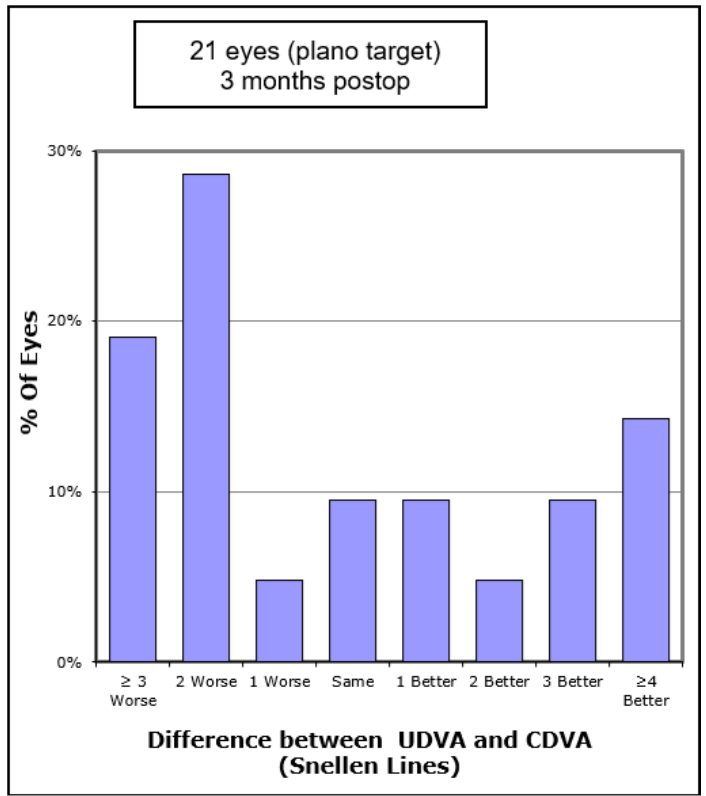
Figure 4. Number of Snellen lines difference between pre-operative CDVA and post-operative UDVA in 21 keratoconic eyes implanted with Ferrara intrastromal corneal ring segments.